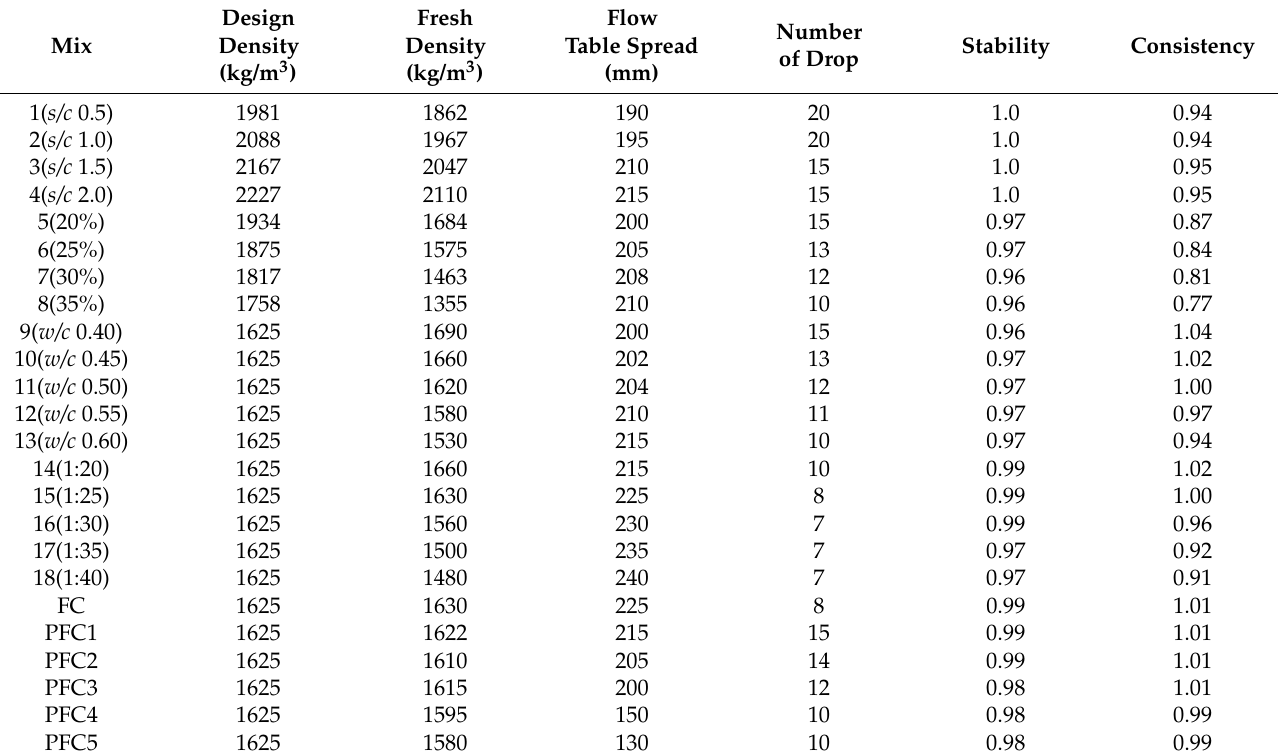
Table 3. Workability of mortar and foamed concrete